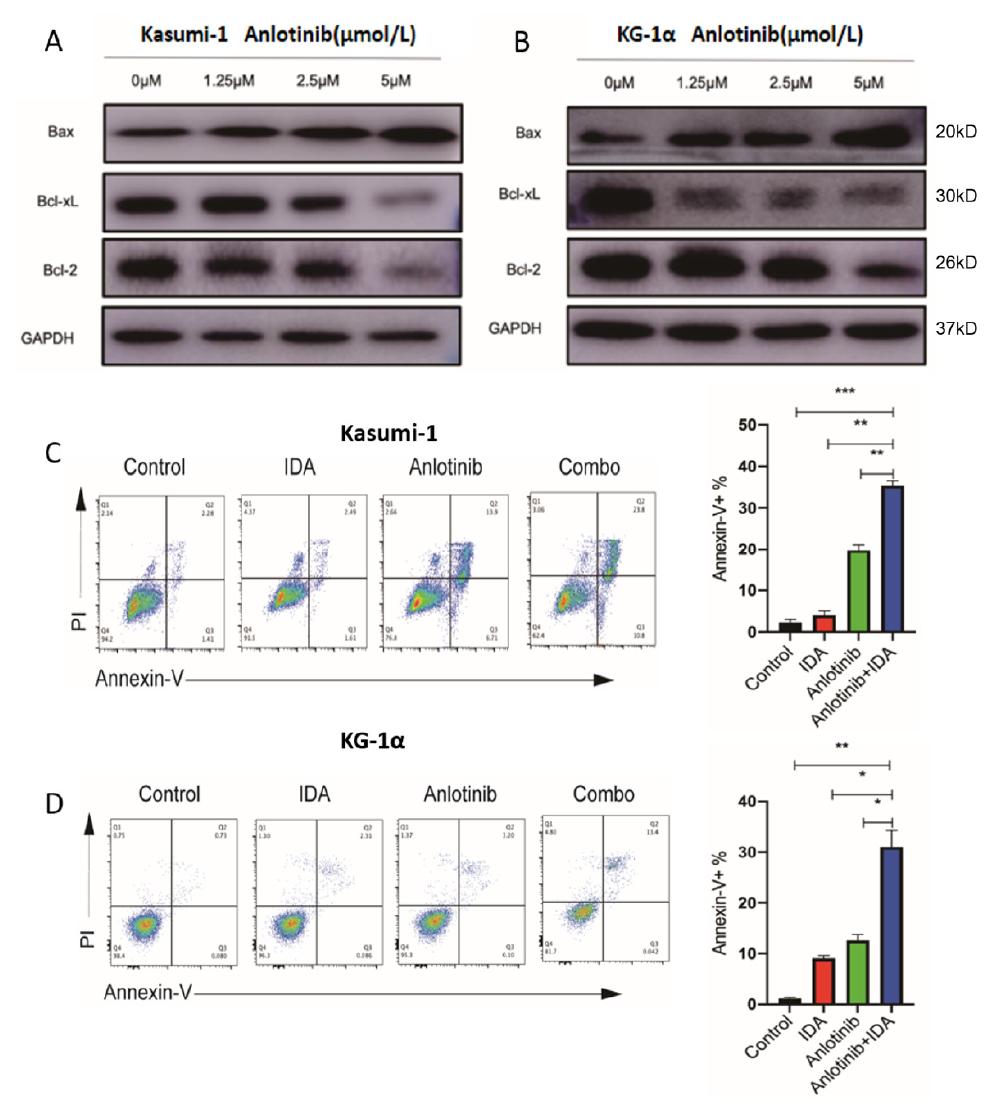
Figure 5. Effects of anlotinib on apoptotic-related proteins in LSC-like cells and its potential in enhancing chemosensitivity of LSC-like cells. ( A , B ) Western blot analysis of Bax, BCL-2, and BCL-xL in Kasumi-1 cells ( A ) and KG-1 α cells ( B ) after anlotinib treatment with indicated concentration for 12 h. ( C , D ) Apoptosis of Kasumi-1 cells ( C ) and KG-1 α cells ( D ) after monotherapy of anlotinib (2.5 μ M), IDA (30 nM), and combinatory therapy of anlotinib (2.5 μ M) and IDA (30 nM) for 48 h. * p < 0.05, ** p < 0.01, *** p < 0.001.